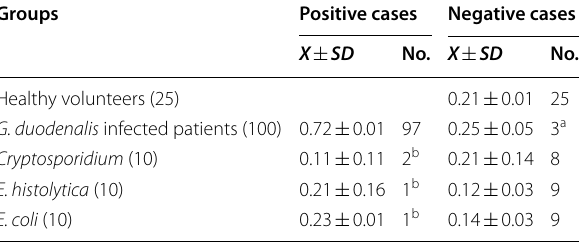
Table 2 Detection of G. duodenalis cyst antigens in stool